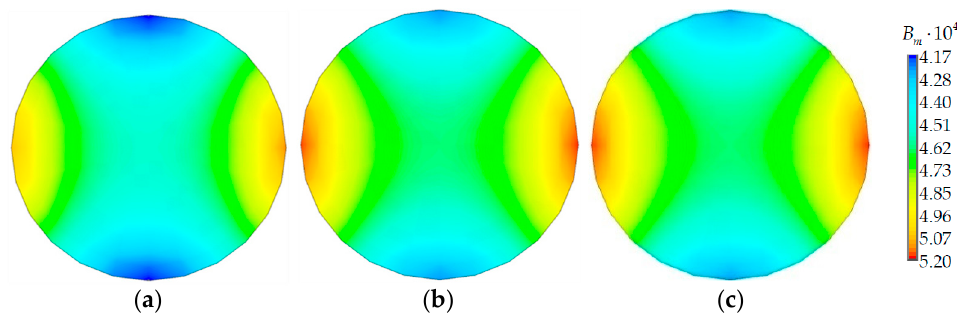
Figure 6. Material birefringence: ( a ) where R coil = 5 mm; ( b ) where R coil = 22 mm; ( c ) where = mm. R coil = 50